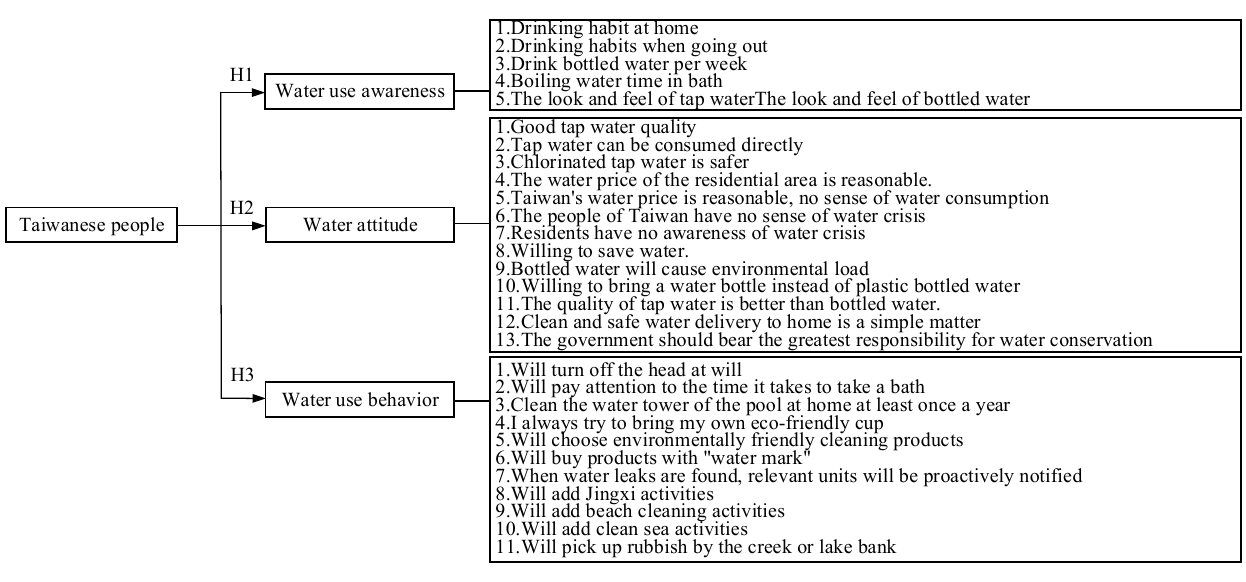
Figure 1. The research structure.